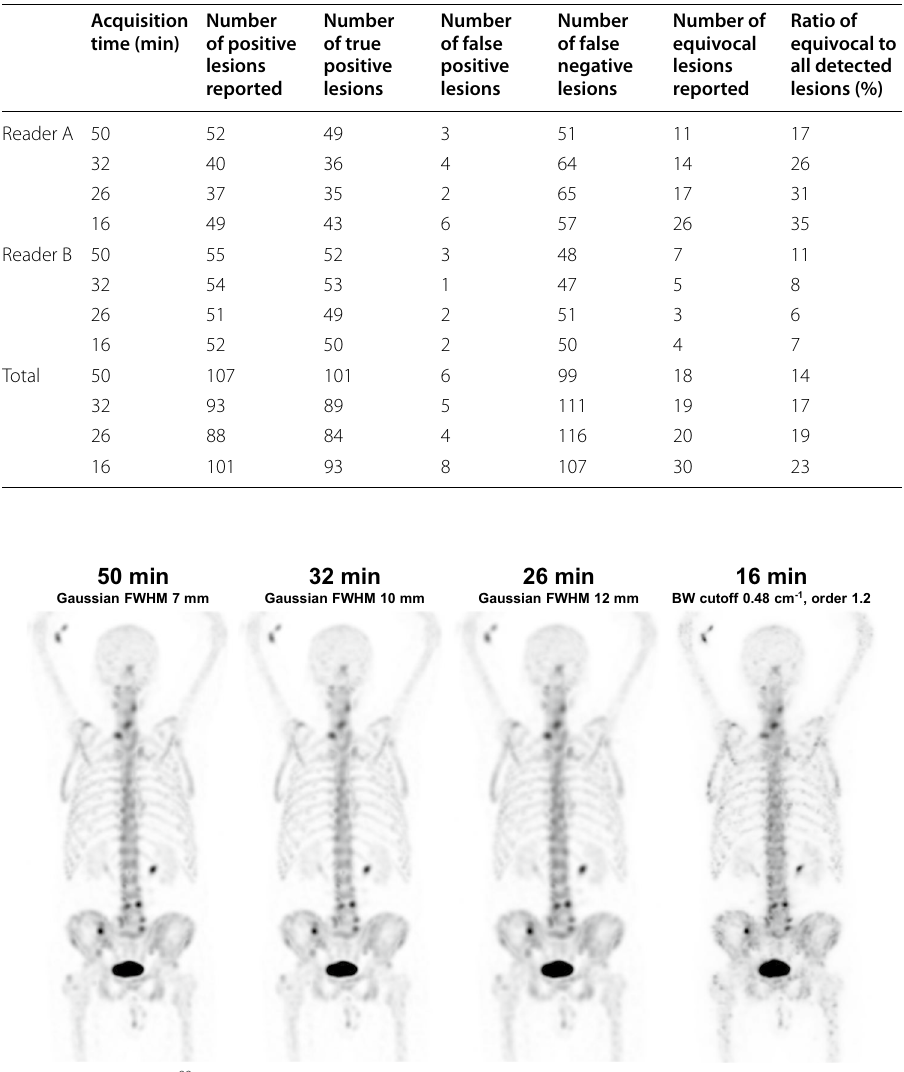
respectively. Examples of images with different acquisition times and filters are shown in Fig. 2.